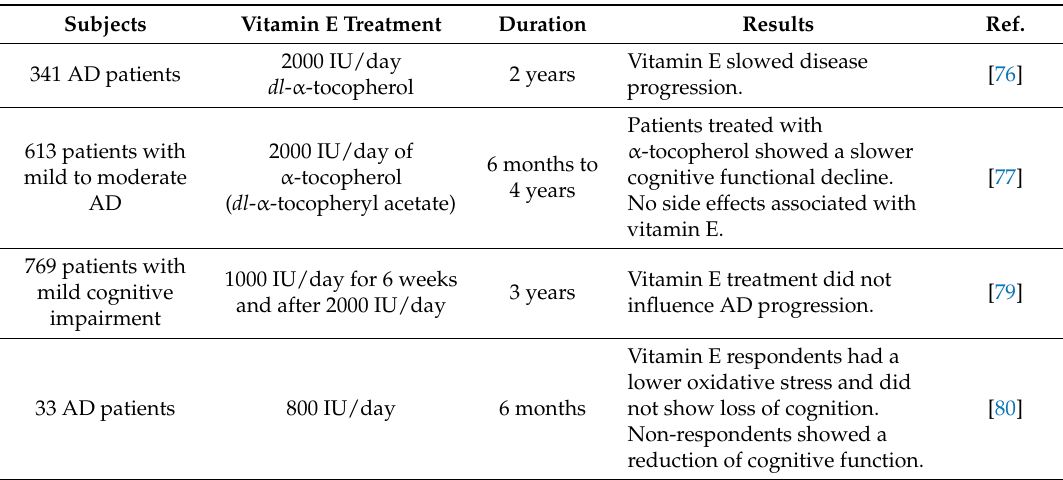
Table 3. Clinical trials evaluating vitamin E supplementation in AD